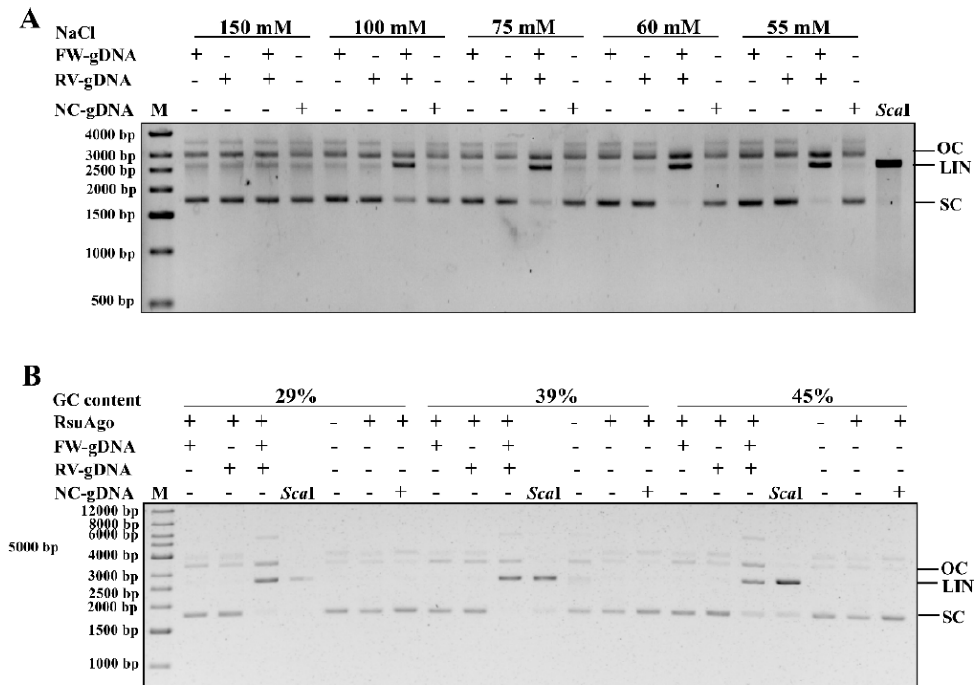
Figure 7. Cleavage of double-stranded plasmid DNA by RsuAgo. ( A ) RsuAgo-mediated cleavage of plasmid pUC19 at different NaCl concentrations. RsuAgo and a gDNA with 29% GC-content were preincubated for 30 min at 37 ◦ C, followed by addition of pUC19 dsDNA, incubation for 2 h at 37 ◦ C in reaction buffer containing 0.5 mM Mn 2+ and cleavage analysis by 1% agarose gel electrophoresis. ( B ) RsuAgo-mediated plasmid pUC19 cleavage with gDNAs differing in their GC-content in reaction buffer containing 0.5 mM Mn 2+ and 55 mM NaCl for 2 h at 37 ◦ C. Sca I lane: the isolated plasmid was digested with Sca I for 2 h. FW/RV-gDNA, forward and reverse gDNA corresponding to a specific target site in plasmid pUC19; NC-gDNA, a non-complementary gDNA control; M, molecular weight marker; LIN, linearized plasmid; SC, supercoiled plasmid; OC, open circular plasmid. All cleavage experiments were carried out in triplicates.